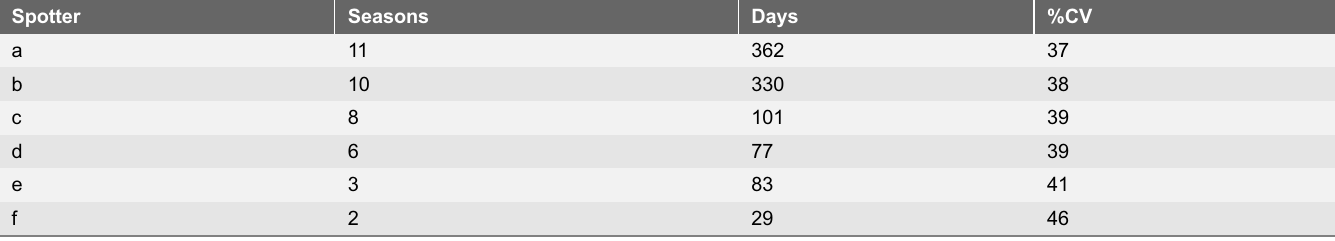
Table 3. Estimated coefficients of variation (CV) for Spotter treated as a random effect. Spotter